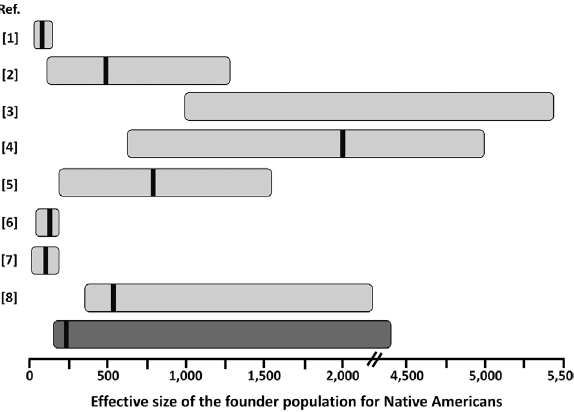
Figure 3 - Schematic representation of estimates of the founder popula- tion size for Native Americans from this (dark gray bar) and previous (light gray bars) studies. The horizontal bars represent the approximate 95% credible interval for the published values. Point estimates, when re- ported, are represented by the black vertical bar within the horizontal bars. Pleasenotethediscontinuityinthe x -axisbetween2,000and4,500.Refer- ences (Ref.) are: 1 – Hey (2005); 2 – Fagundes et al. (2007); 3 – Kitchen et al. (2008);4–Fagundes etal. (2008);5–Gutenkunst etal. (2009);6–Ray et al. (2010); 7 – Wall et al. (2011); 8 – Gravel et al. (2013). The values presented in Hey (2005) were recalculated based on a generation time of 25